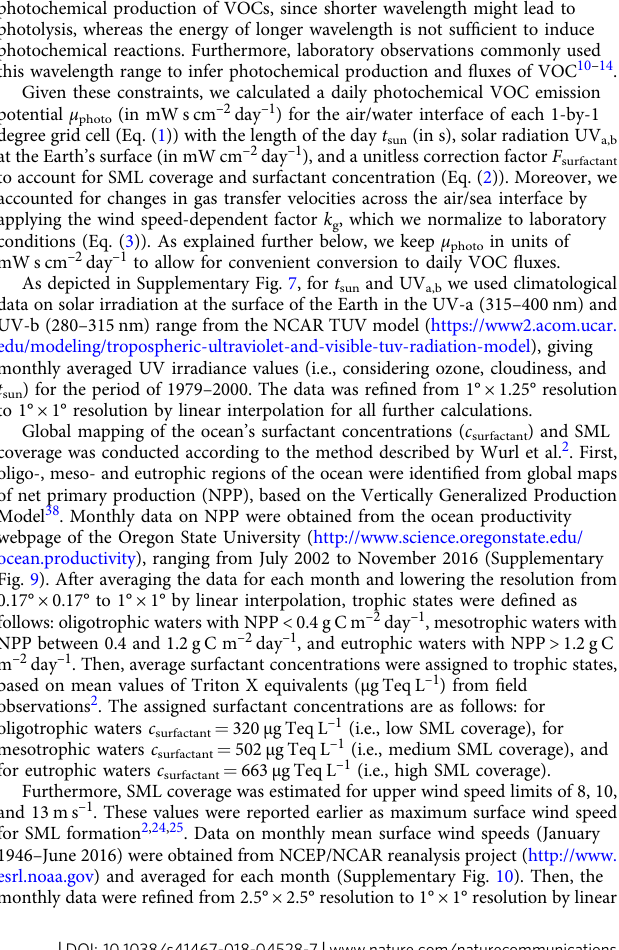
Fig. 7. Moreover, the Matlab code as well as a stand-alone version of the Photo- chemistry At Liquid/Air interfaces containing Surfactants (PhotochemAtLAS) model, including instructions, is publicly available on Bitbucket, an online com- munity repository.